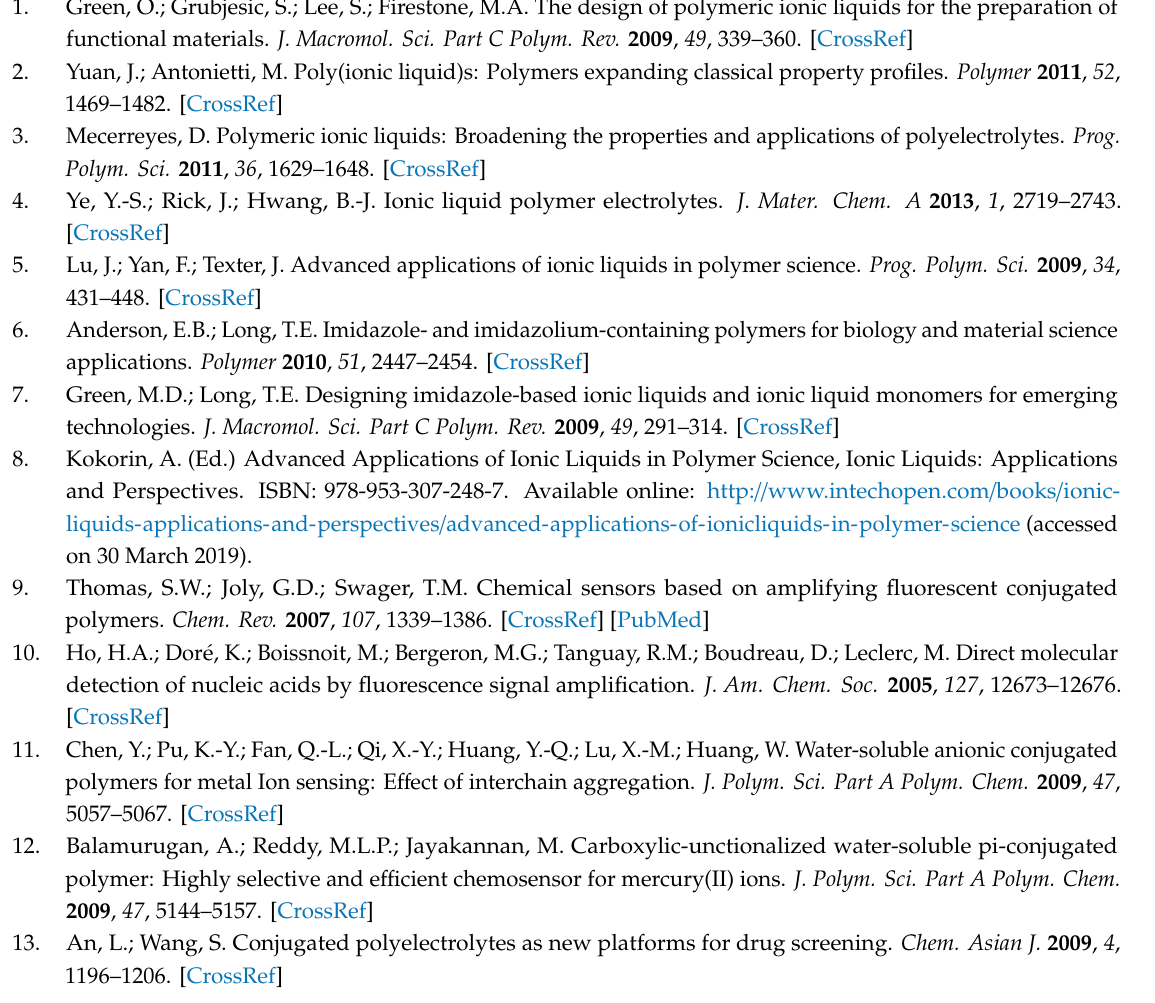
Figure S1: FTIR spectra of polymers II-1 – II-5 , Figures S2–S5: 1 H NMR spectra of polymers II-1 , II-3 – II-5 , Figure S6: XRD patterns of polymers II-3 – II-5 , Figure S7: POM textures of polymer II-1 , Figures S8–S12: Emission spectra of II-1 – II-5 in various organic